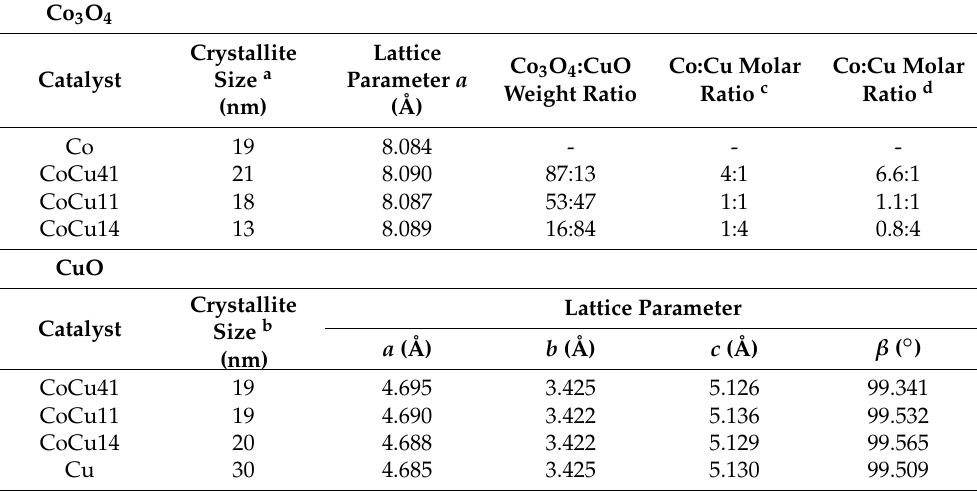
Table 2. Crystallite sizes, lattice parameters, and weight ratios of cobalt and copper oxides (Co 3 O 4 and CuO) in the catalysts determined from powder XRD